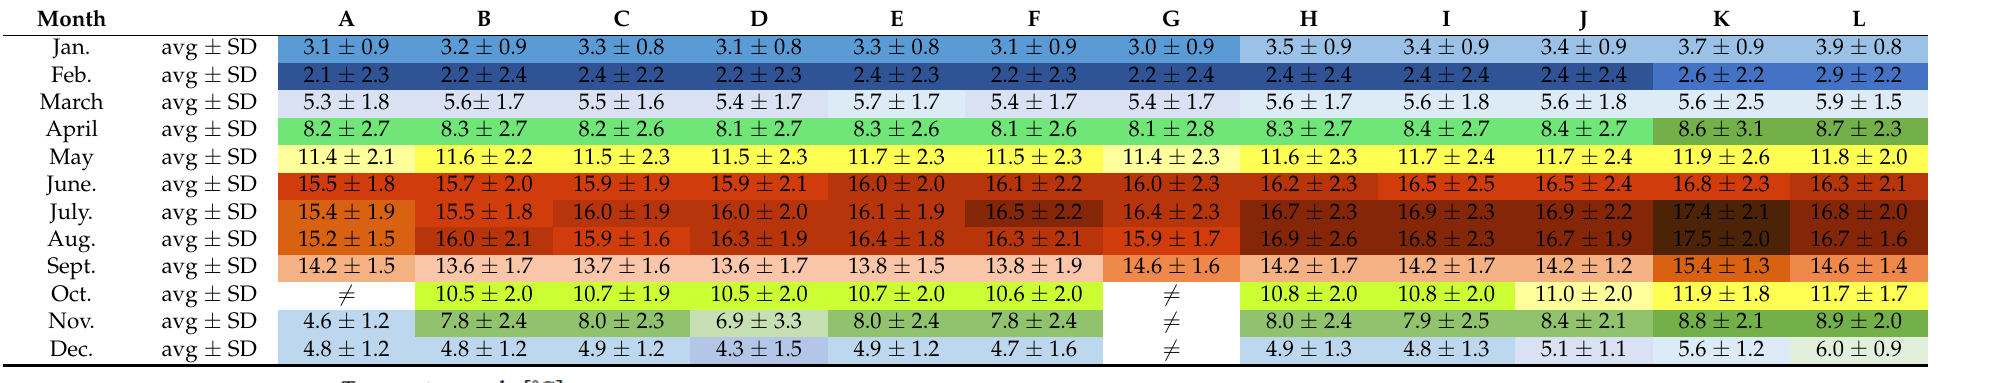
Table 3. The average temperature ( ± SD) of the months January to December (2020–2021) for the stations A–L.